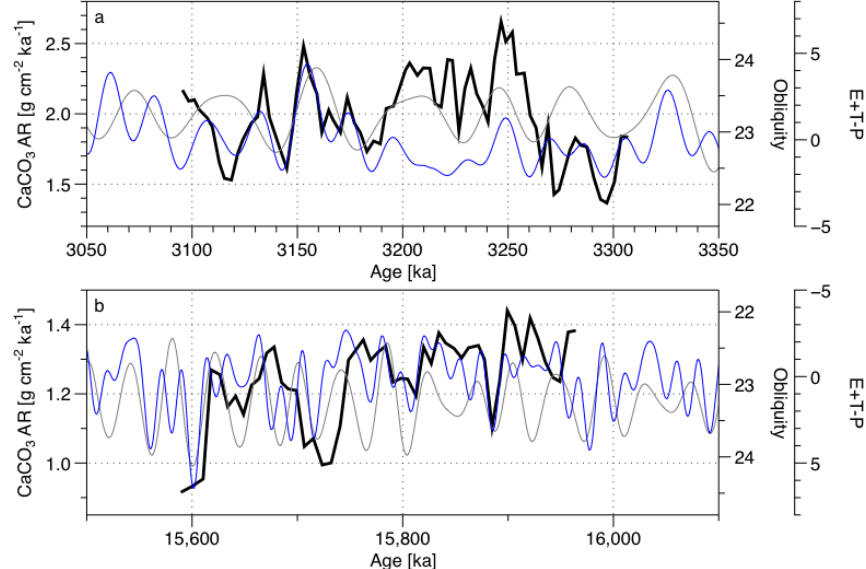
Figure 13. Comparison of the CaCO 3 AR (black) with both the obliquity (grey) and the E + T − P orbital records (blue) (Laskar et al., 2004) for (a) MIS KM5 and (b) the